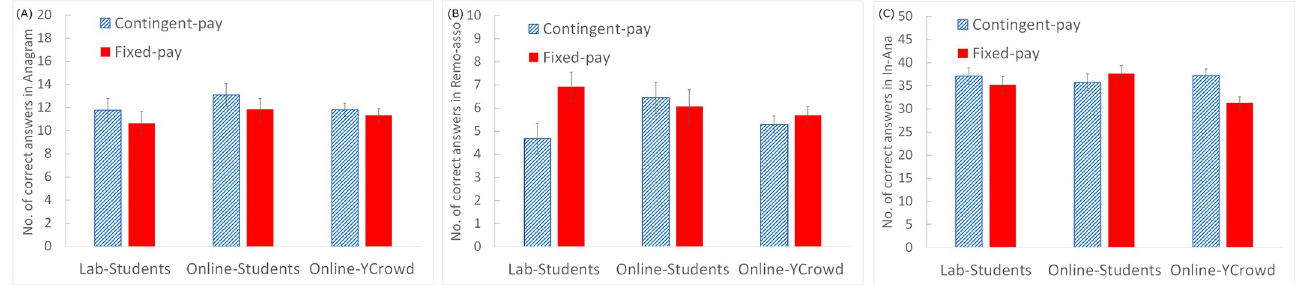
Fig 2. Task performance (number of correct answers) for (A) anagram, (B) remote association, and (C) inverse-anagram tasks. Error bars indicate standard errors. “Online-YCrowd” indicates data of the Yahoo crowdsourcing sample collected in the additional experiment.